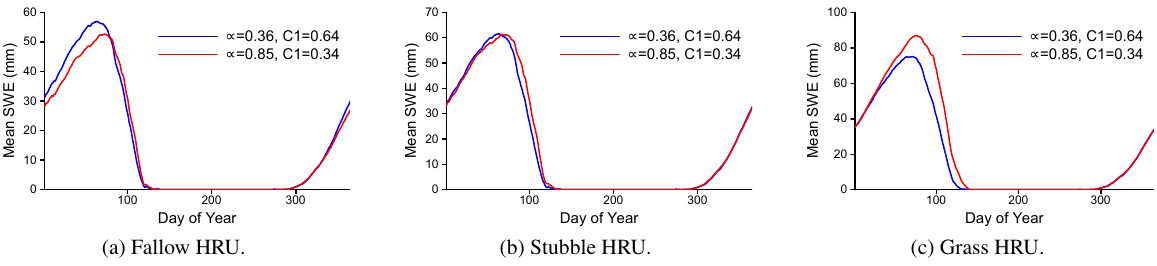
Fig. 10: Mean CRHM simulated snowcover accumulations for three HRUs, based on measured monthly snowfall downscaled to daily values. The curves represent accumulations from downscaled data having α and C1 values of 0.36 and 0.64, and 0.72 and 0.41, respectively, which are similar to the extremes of the values measured in sub-sets of historical data. S 5 = the 5th generation, and n = number of days in given